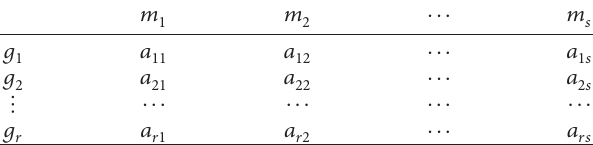
Table 2: Patient and disease information.